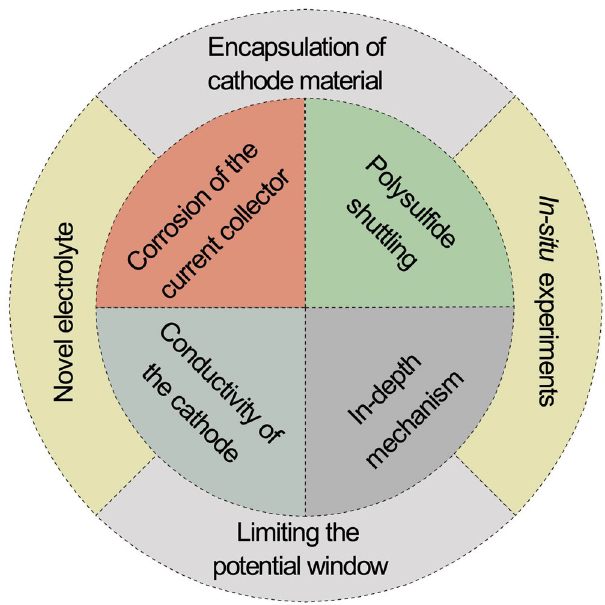
Fig. 5 Current issues of Al – S batteries. Summary of the various aspects of Al – S batteries to be